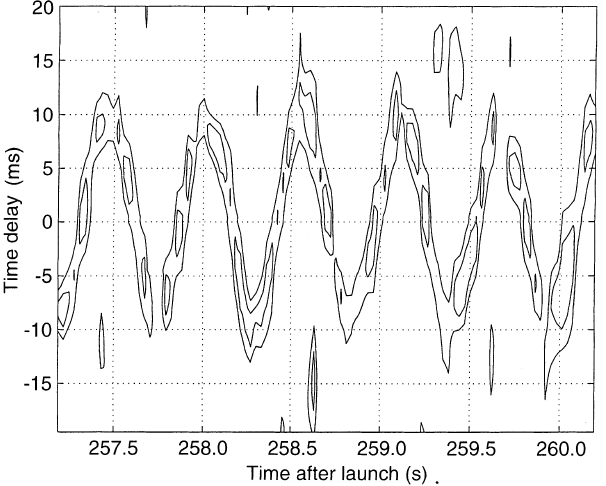
Fig. 6. Contour plot of normalized cross-correlation of the U 1 and U 2 potential di(cid:128)erences is shown over an interval of ROSE F4 downleg flight time. See Fig. 4 for the corresponding altitudes. The frequency range is 5–1000 Hz. The distance between the U 1 and U 2 measuring probe sets is approximately 2.54 m. For simplicity, only the 0.5 and 0.75 contours are shown